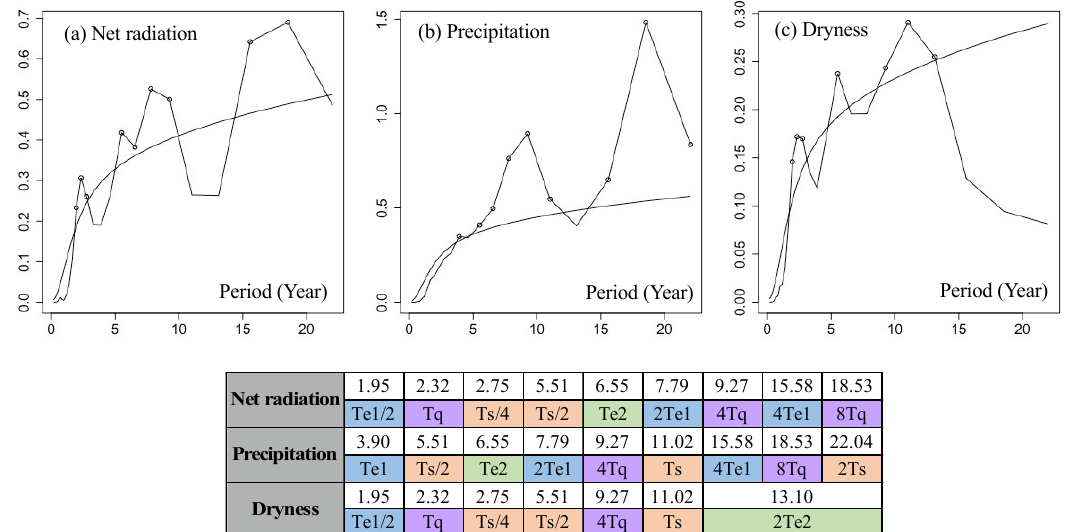
Figure 7. The time ‐ averaged power spectrum from Morlet wavelet transform of SFA ‐ extracted (m = 13) slow feature signals (jagged curves) for ( a ) net radiation, ( b ) precipitation, and ( c ) dryness. The significant points (dots) which pass the significance test at the 0.05 significance level (smooth line) are listed and classified, including the biennial annular mode oscillation (BAMO) and/or the quasi ‐ biennial oscillation (QBO) in purple (Tq), the El Niño–Southern Oscillation (ENSO) in blue (Te1) and green (Te2), and sunspot cycle in orange (Ts).